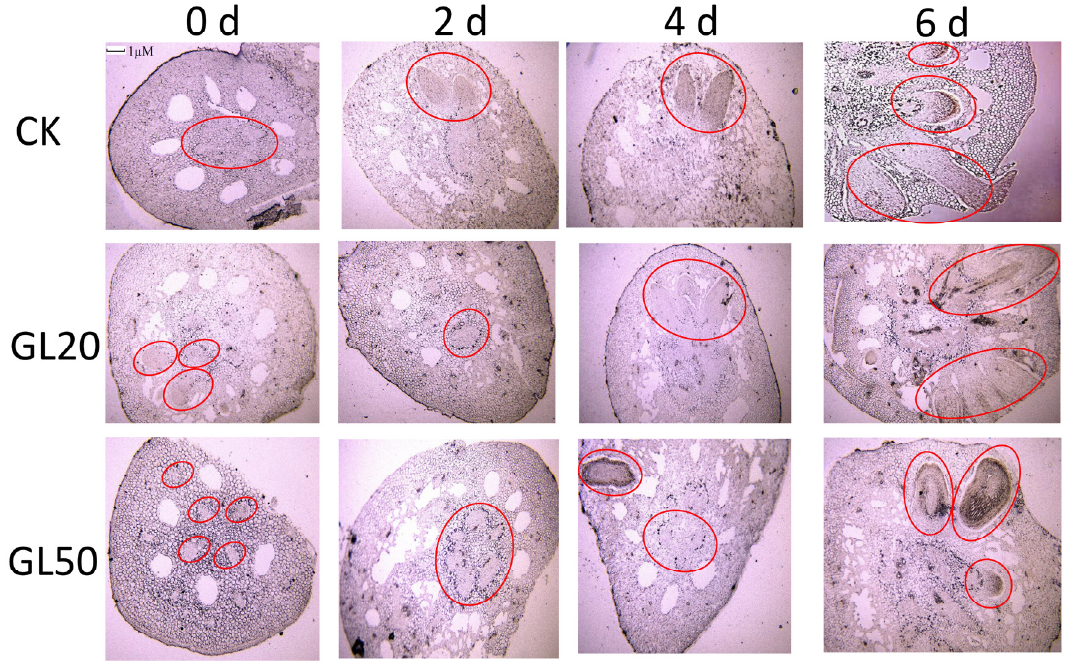
Figure 2. The change in lignin synthesis based on an observation of the microstructure during AR formation in lotus seedlings treated with 20 g/L and 50 g/L sucrose. GL20 represents 20 g/L treatment and GL50 represents 50 g/L treatment. The seedlings were firstly treated with 20 g/L and 50 g/L sucrose, and then transferred into water for continue growth. The hypocotyls at 0 days, 2 days, 4 days, and 6 days after transfer were collected for microstructure